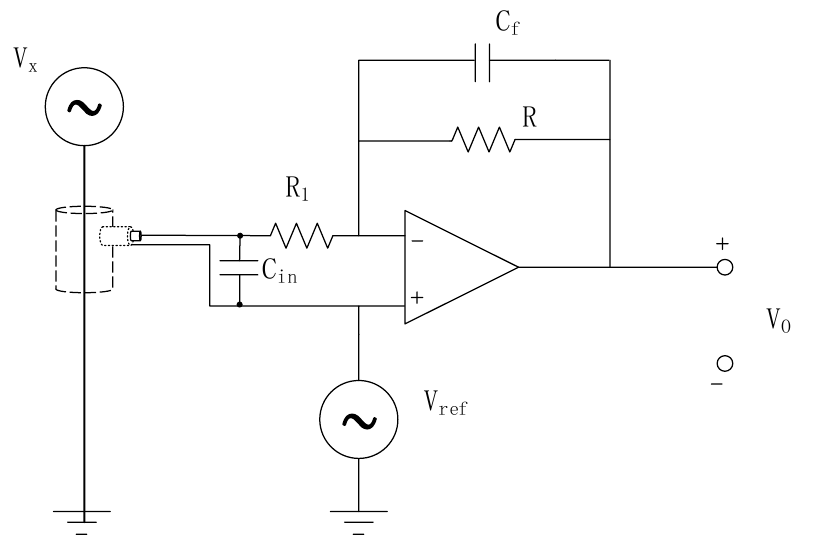
Figure 8. Physical diagram of probe: ( a ) schematic diagram of internal structure of probe; ( b ) sche- matic diagram of external structure of probe.